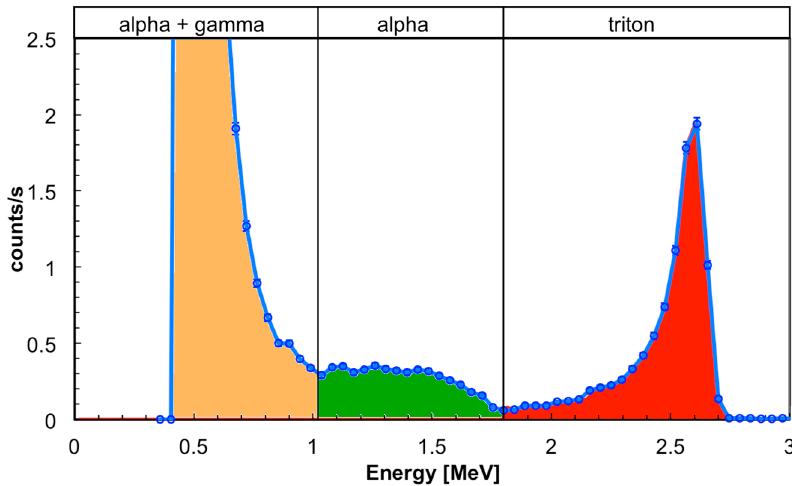
Figure 9. Deposited energy spectrum measured from the LiF01 sample (1.8 µm nominal thickness) placed on a 3 × 3 cm 2 silicon detector exposed to a thermalized AmBe neutron source.